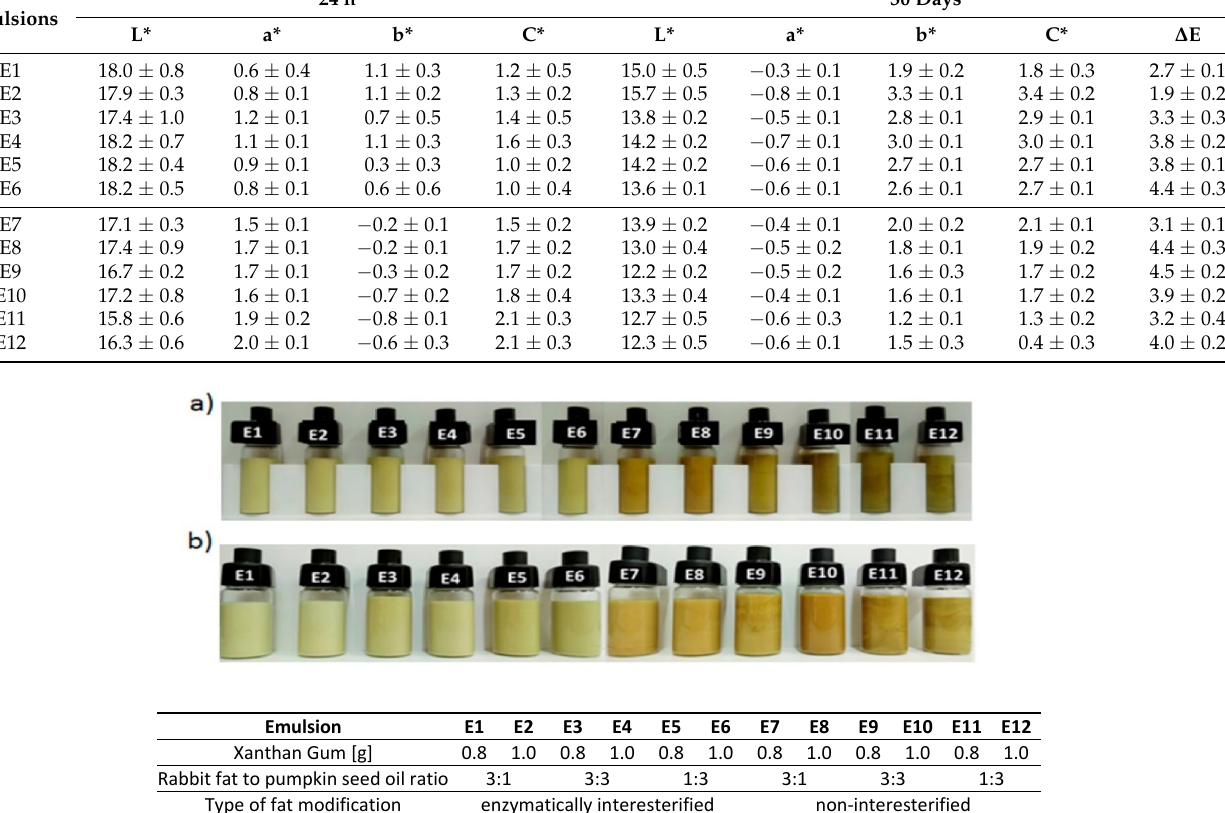
based on structured lipids, which evidenced of their brighter color (Table 2, Figure 3). The values of this parameter decreased after 30 days of storage of all the emulsions by approx. Table 2. Changes in color parameters of the prepared emulsions after 24 h and 30 days from their preparation (mean values ± standard deviation). Emulsions